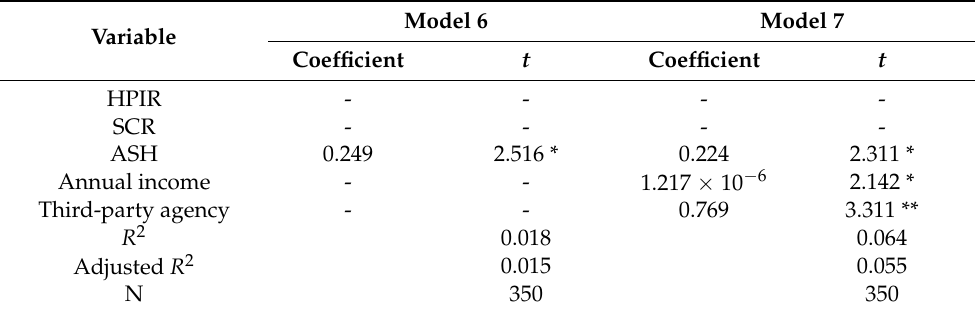
Table 7. The impacts of various factors on actors’ supportive perception in Shenzhen. Model 6 Model Variable